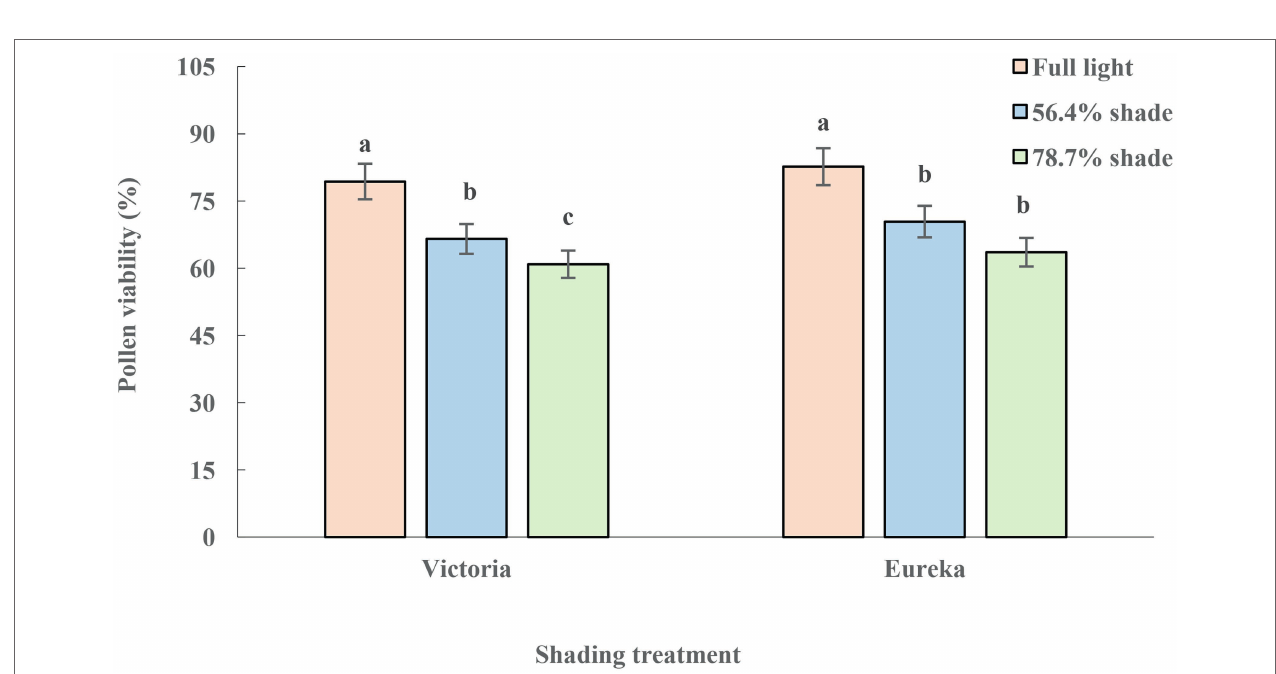
FIGURE 2 | Pollen viability of two alfalfa cultivars under different shading levels. Different letters indicate significant differences ( p <